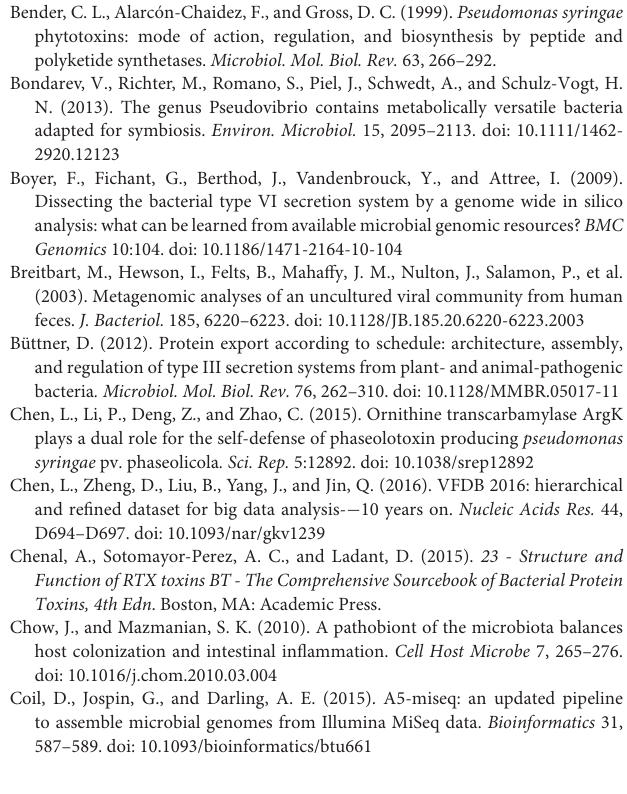
Table S7 | Probable toxin-like homologous of P. brasiliensis Ab134 T were identified by BLASTP search against the virulence factors database. Rows showing redundant functions are highlighted in